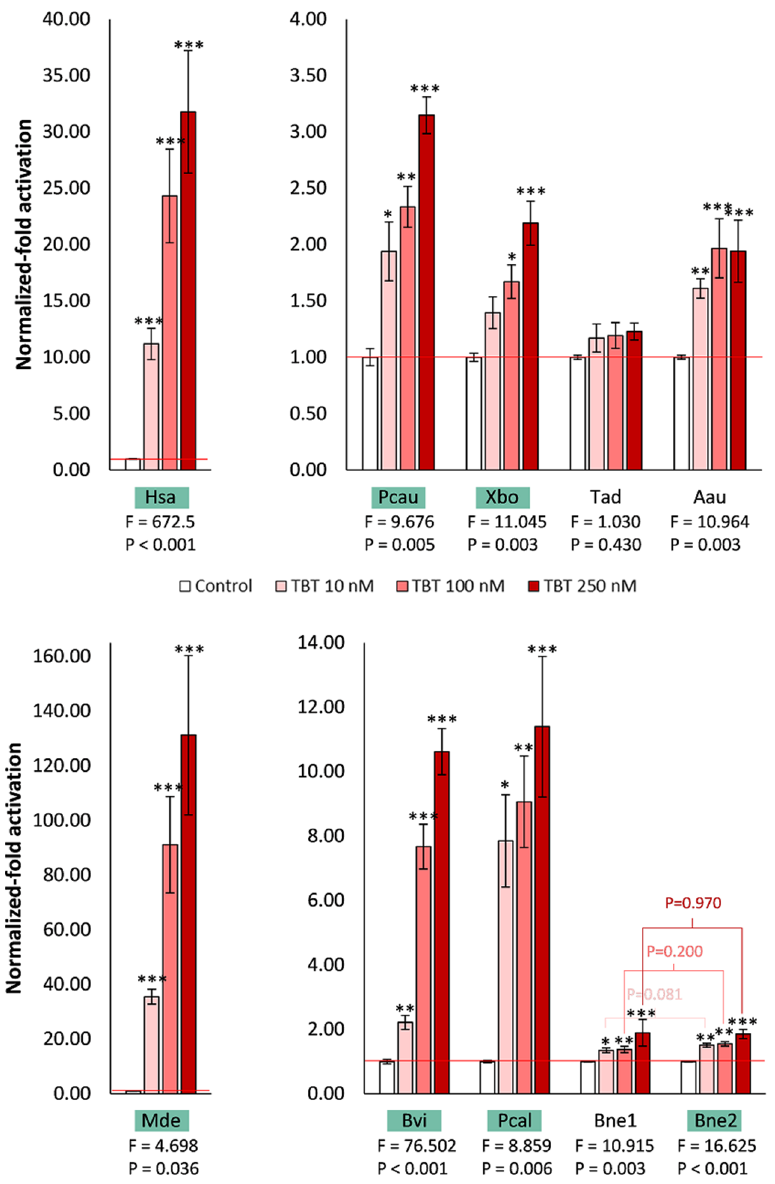
Figure 4. Transactivation activity of the luciferase reporter gene mediated by GAL4 DBD–RXR LBD chimeric receptors in COS-1 cells in the presence of TBT. Data represent means ± SEM from three separate experiments (n = 3). The results were normalized to the control condition (DMSO without ligand). Significant differences between the tested concentrations of TBT and the solvent control were inferred with one-way ANOVA. The F and P values of the source of variation are indicated below each species name abbreviation. Asterisks denote significant differences (* P ≤ 0.05, ** P ≤ 0.01, *** P